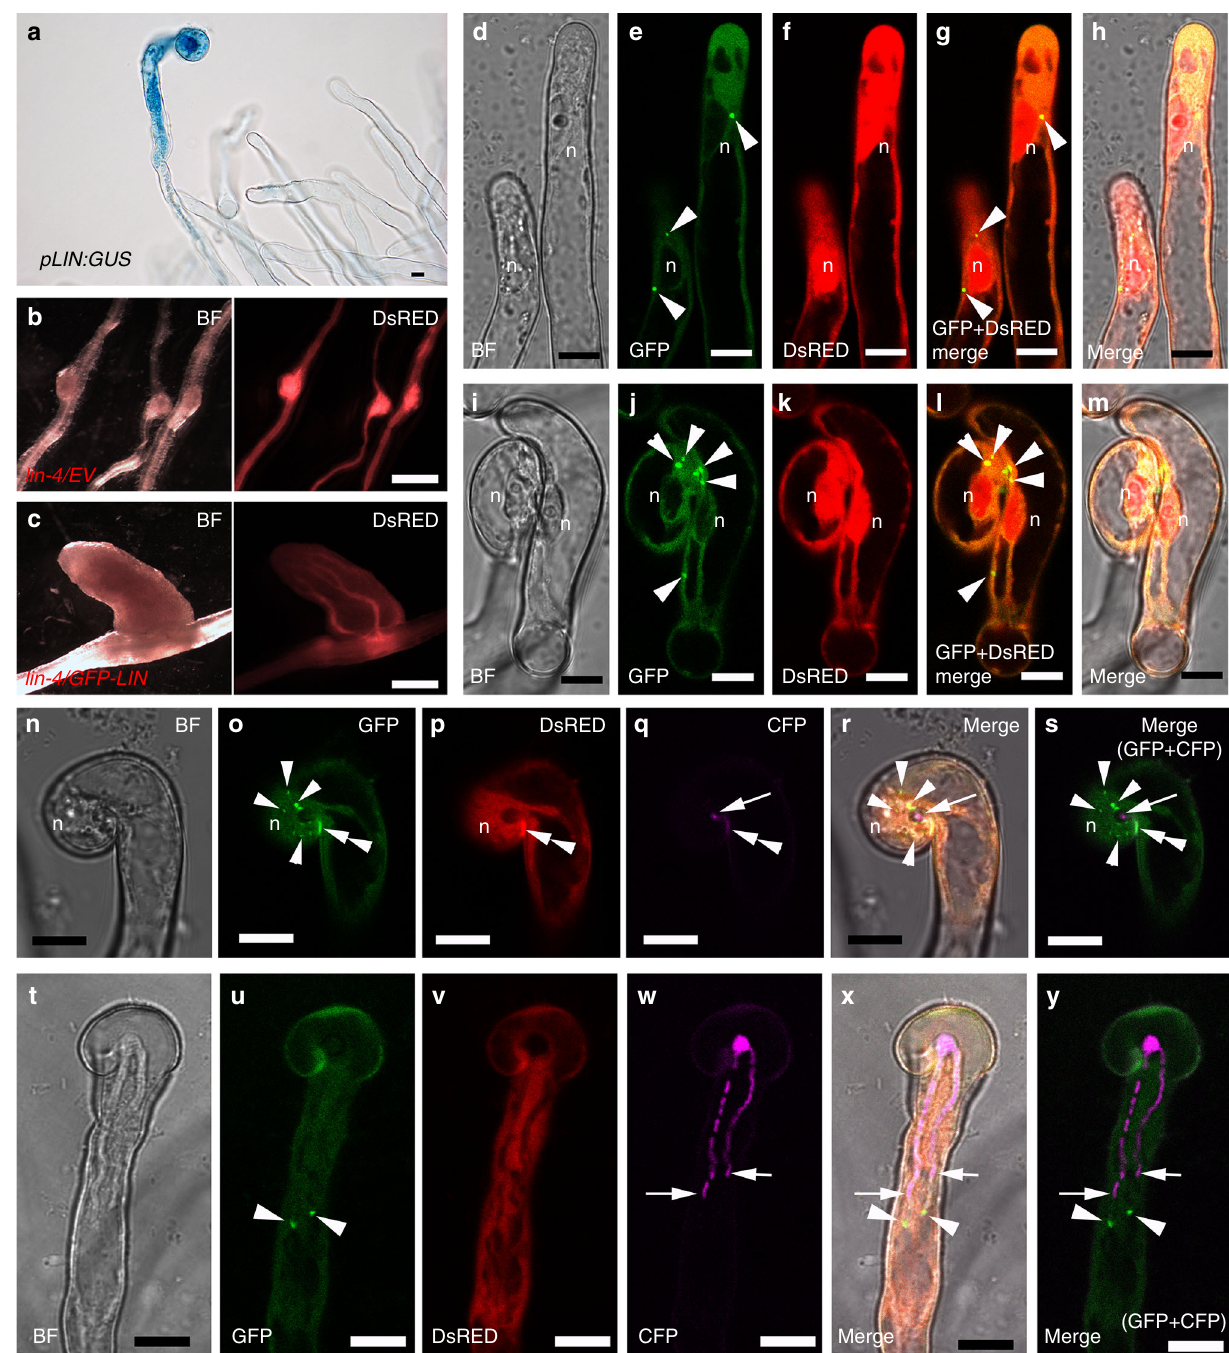
Fig. 4 Expression of LIN and subcellular localization of LIN in root hairs during rhizobial infection. a Expression of pLIN:GUS in a root hair harbouring an infection thread. b – c Nodules from lumpy infections-4 ( lin-4 ) mutants transformed with an empty vector (EV) ( b ) or pLIN:GFP-LIN construct ( c ). Bright fi eld (BF), left and DsRED images, right in b and c . d – y Live cell confocal images of subcellular localization of GFP-LIN driven by pLjUBQ1 promoter in root hairs throughout different stages of rhizobial infection: GFP-LIN accumulated in puncta associated to the nuclear periphery in non-deformed root hairs ( d – h ); GFP-LIN labelled dot-like bodies were also found around rhizobial micro-colony and neighboring nucleus during infection chamber development ( i – m , n – s ); and fi nally, GFP-LIN also accumulated at the tip of infection threads, just ahead of the elongating structure ( t – y ). DsRED was used as a transgenic marker (red). Transgenic plants were either inoculated with Rm1021-lacZ ( a – c ) or Rm1021-CFP ( d – y , magenta in q – s , w – y ). Plants were imaged from 2 dpi up to 7 dpi ( d – y ). GUS staining is shown as blue. DsRED, GFP, CFP were pseudo coloured in red, green and magenta, respectively. n, nucleus. Arrowheads, GFP- LIN puncta. Arrows, CFP tagged rhizobia. Double arrowheads, auto- fl uorescence. Scale bars, 10 µ m ( a , d – y ) and 500 µ m ( b , c